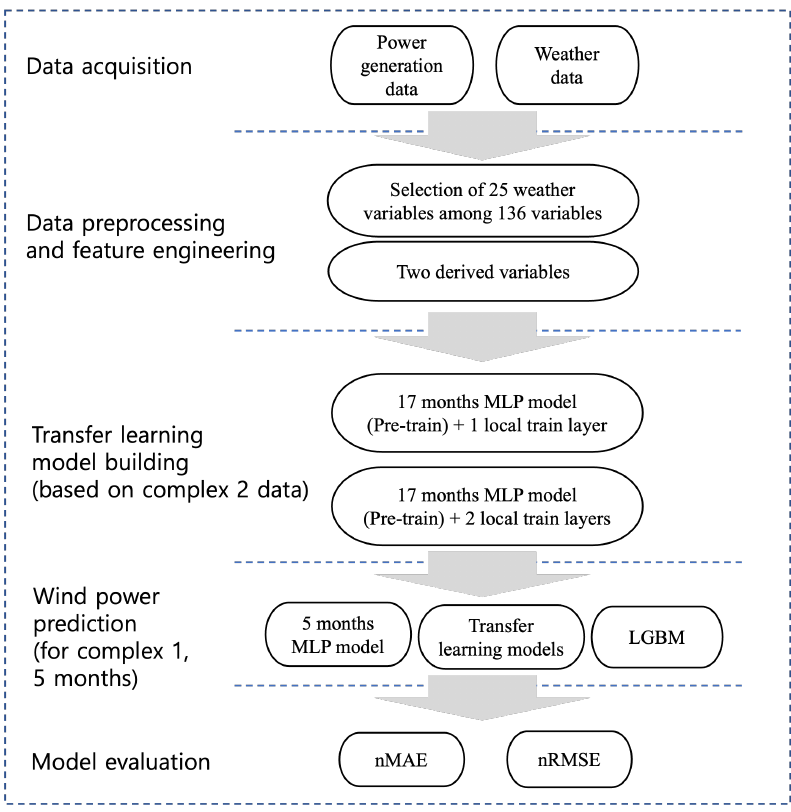
Figure 3. Overview of the proposed